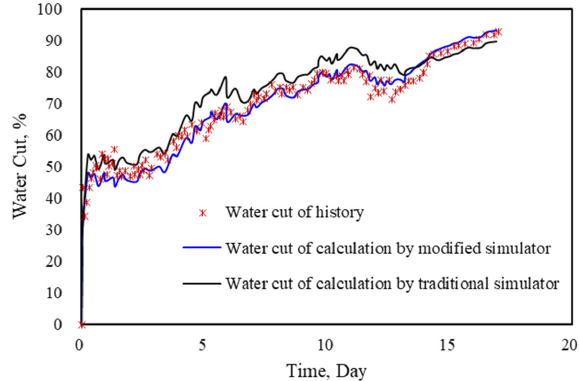
Figure 14. Fitting results of water cut in the whole well area.